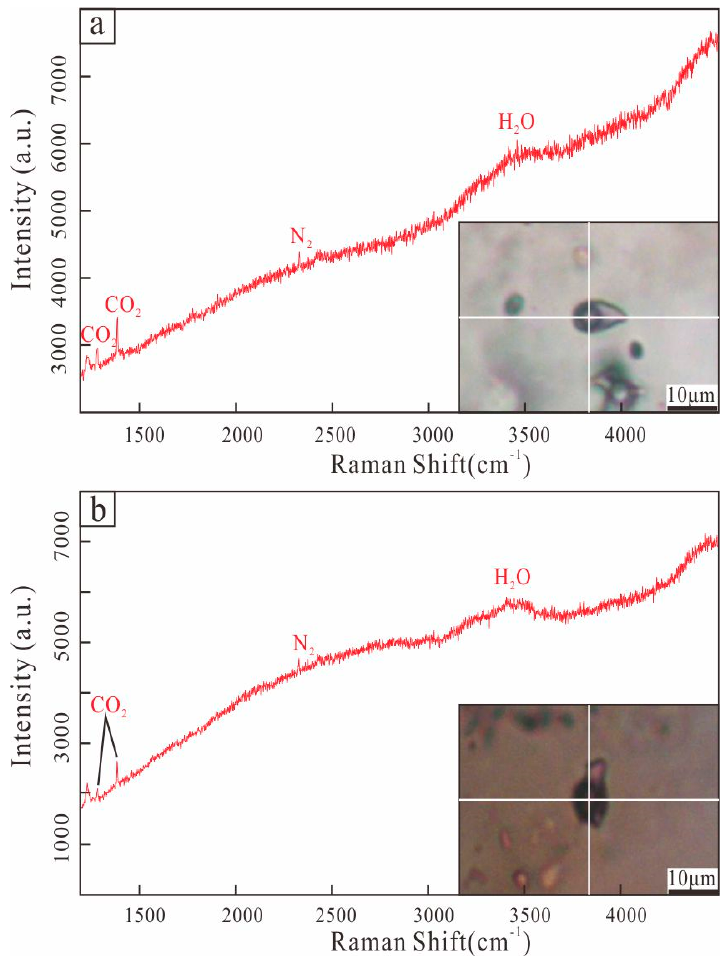
Figure 8. Representative laser Raman spectra for fluid inclusions from the Chuduoqu Pb-Zn-Cu deposit. ( a ) H 2 O, N 2 and CO 2 spectra of the vapor phase in L-type inclusion; ( b ) H 2 O, N 2 and CO 2 spectra of the vapor phase in V-type inclusion.